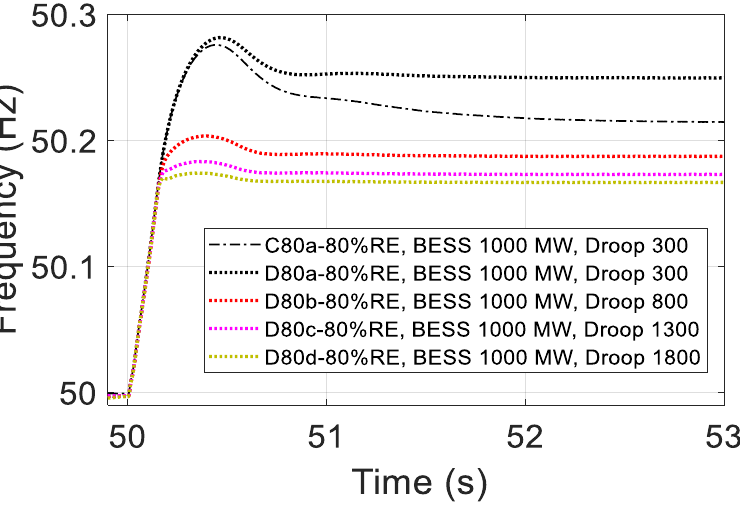
Figure 13. Frequency response of the system when a fixed BESS capacity provides PFC using different droop coefficients under an 80% RE penetration scenario.